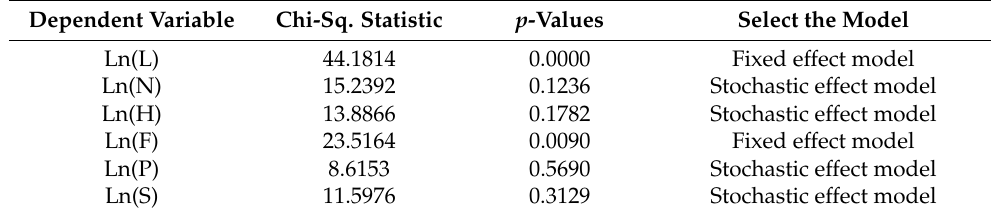
Table 5. Hausman test